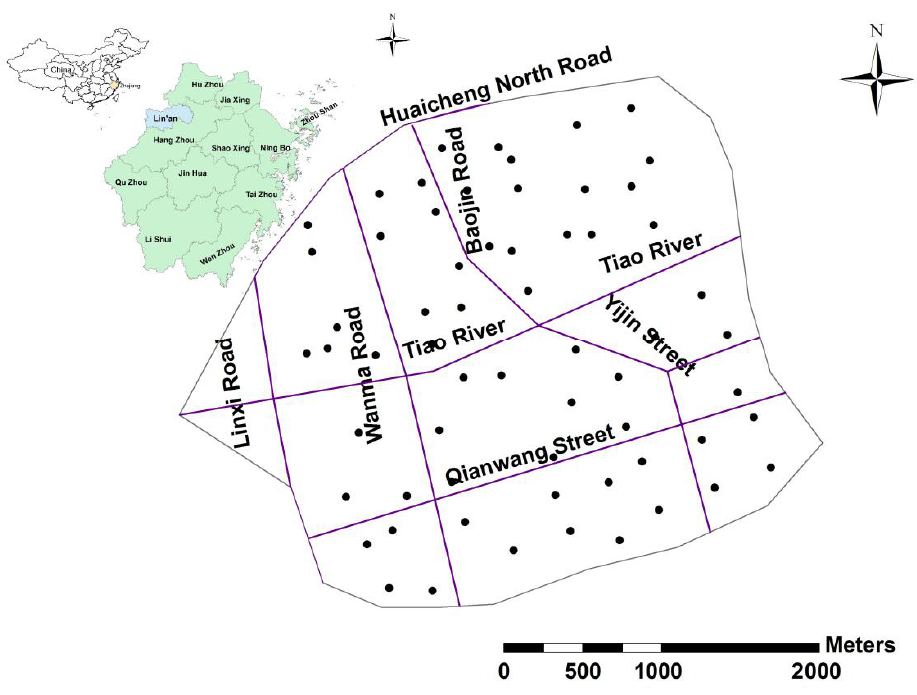
Figure 1. Spatial distribution map of soil sampling sites.